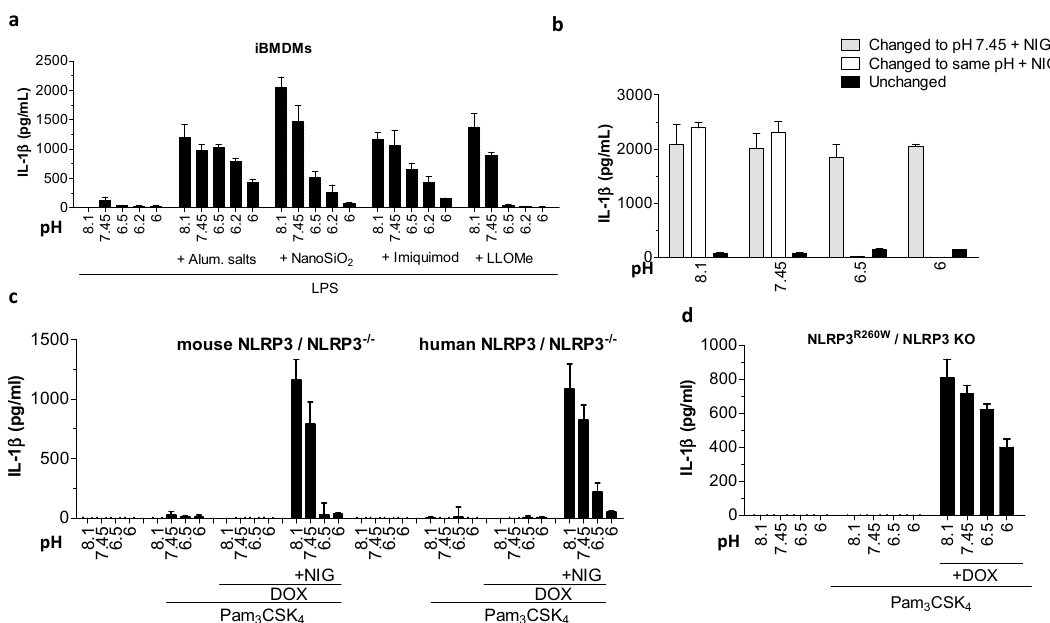
Figure 3. Acidic pH decreased IL-1 β secretion due to NLRP3 inflammasome canonical and constitutive activation. ( a ) IL-1 β levels by ELISA after iBMDMs were primed with 100 ng/mL LPS for 6 h and treated 3 h with buffers with various pH values alone or containing 400 μ g/mL aluminum salts, 180 μ g/mL nanoSiO 2 , 20 μ M imiquimod, or 1 mM LLoMe. ( b ) IL-1 β levels by ELISA assay in supernatants after iBMDMs were primed as in ( a ) and then incubated for 1 h in buffers with various pH values. Cells were then for another hour in either the same pH condition (unchanged), switched to a buffer with the same pH condition containing nigericin, or buffer with pH 7.45 containing 10 μ M nigericin. ( c , d ) IL-1 β levels by ELISA released from iBMDMs expressing reconstituted mouse or human NLRP3 ( c ) or NLRP3 R260D mutant ( d ) after overnight priming with 200 ng/mL Pam 3 CSK 4 and 0.5 μ g/mL doxycycline, followed by 1 h incubation in buffers with various pH values alone ( c , d ) or containing 10 μ M nigericin ( c ). 2.2. Under Acidic Conditions, Murine Macrophages Suppressed IL-1 β Activation in Response to Various NLRP3 Inflammasome Triggers The inability of murine macrophages to secrete IL-1 β in response to acidic pH prompted us to assess the effects of NLRP3 inflammasome triggers on the IL-1 β activation under acidic conditions. Not only did murine iBMDM in the presence of low pH yield no IL-1 β , its secretion and pyroptosis in response to nigericin were also markedly suppressed when stimulation was performed in the acidic buffer (Figure 2a,b). Furthermore, an increase in cell viability as judged from XTT assay was observed when nigericin treatment was performed in acidic pH, which correlated to a decrease in pyroptosis (Figure 2b,c). The same trend in IL-1 β release suppression was observed with other murine phagocytes, primary mouse bone marrow-derived macrophages (BMDMs), and immortalized microglial cells (Figure 2d,e). The IL-1 β maturation inhibition was further followed by Western blot (Figure 2f). While the amount of expressed cytokine precursor pro-IL-1 β after incubation in acidic conditions alone was intact, thus excluding the effects on the precursor expression, we found a decreased amount of mature form of IL-1 β (p17) in the cell supernatant as a result of nigericin treatment in acidic conditions. While very prominent with nigericin, this acidosis-related inhibitory effect was also observed with a wide array of other, chemically diverse NLRP3 instigators (Figure 3a) and was thus unlikely a consequence of potential trigger inactivation under acidic conditions.